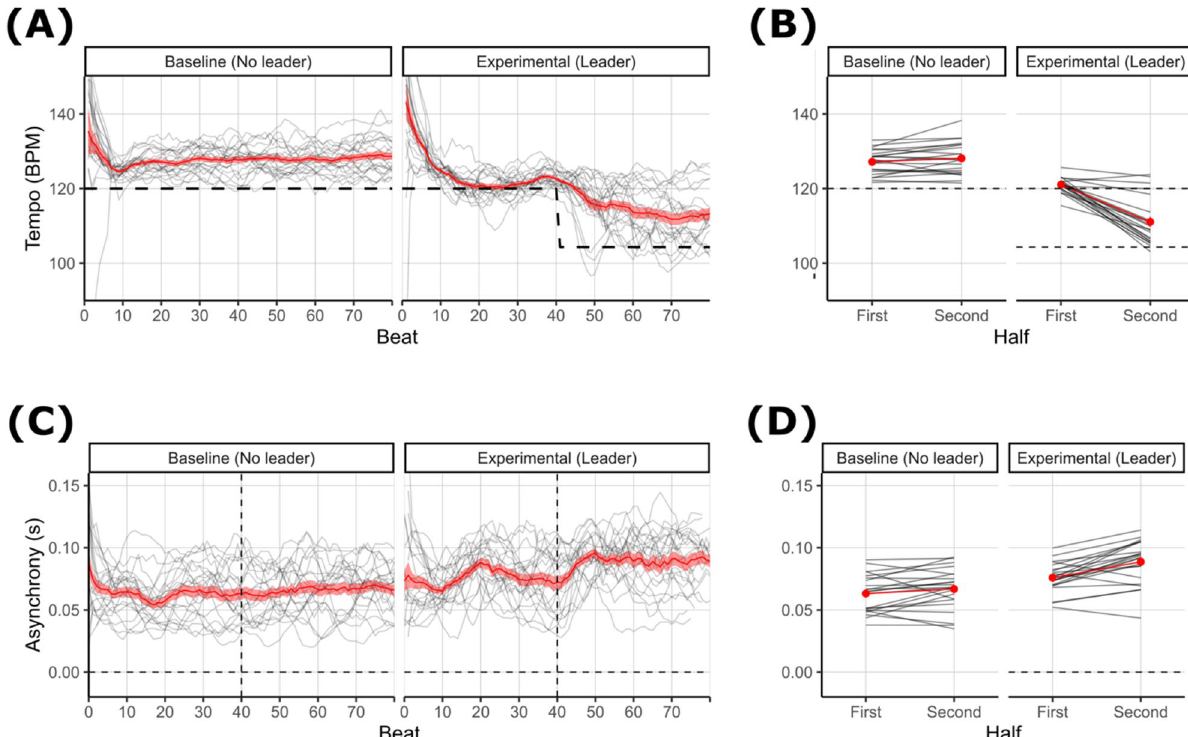
Figure 2. Coordination measures over time ( A – C ) and aggregated within each half of each trial ( B – D ). Black lines show individual groups. Red lines show mean ± SEM. Temporal data is smoothed using a 6-beat sliding window for visualisation. The R software 78 package tidyverse version 1.3.0 79 (https:// doi. org/ 10. 21105/ joss. 01686) was used to plot these figures. ( A , B ) Coordination with the target tempo over time ( A ) and aggregated across groups ( B ). The y-axis shows movement tempo in beats per minute (BPM) and dashed lines represent the target tempo, which changes from 120 to 104 BPM after 20 s on experimental trials. ( C , D ) Coordination with the group members over time ( C ) and aggregated across groups ( D ). The y-axis shows the standard deviation of the step times of six participants in a group, in